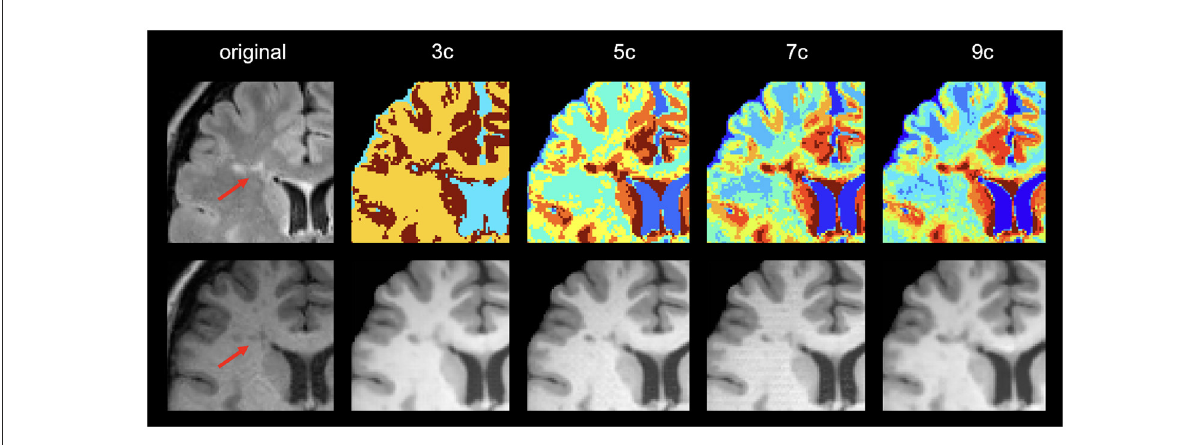
FIGURE5 Example of image generations in a lesion area. First column shows the original T2-FLAIR and T1 image. The rest of the columns show the clustering result and the corresponding generated image using different numbers of clusters (3, 5, 7, and 9, respectively).